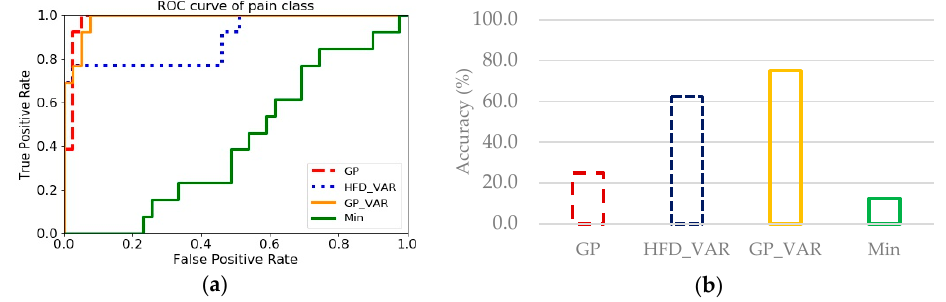
Figure 8. Comparison between the features of two feature groups: Variance based (GP, HFD_VAR, GP_VAR), and Fisher score based (GP, HFD_VAR, Min) for four ‐ level classification: ( a ) ROC curves of each FD ‐ based feature and Min for pain perception levels; ( b ) Classification accuracy of each FD ‐ based (corresponding to results without Fisher score ‐ based channel selection from Table 3) and Min.